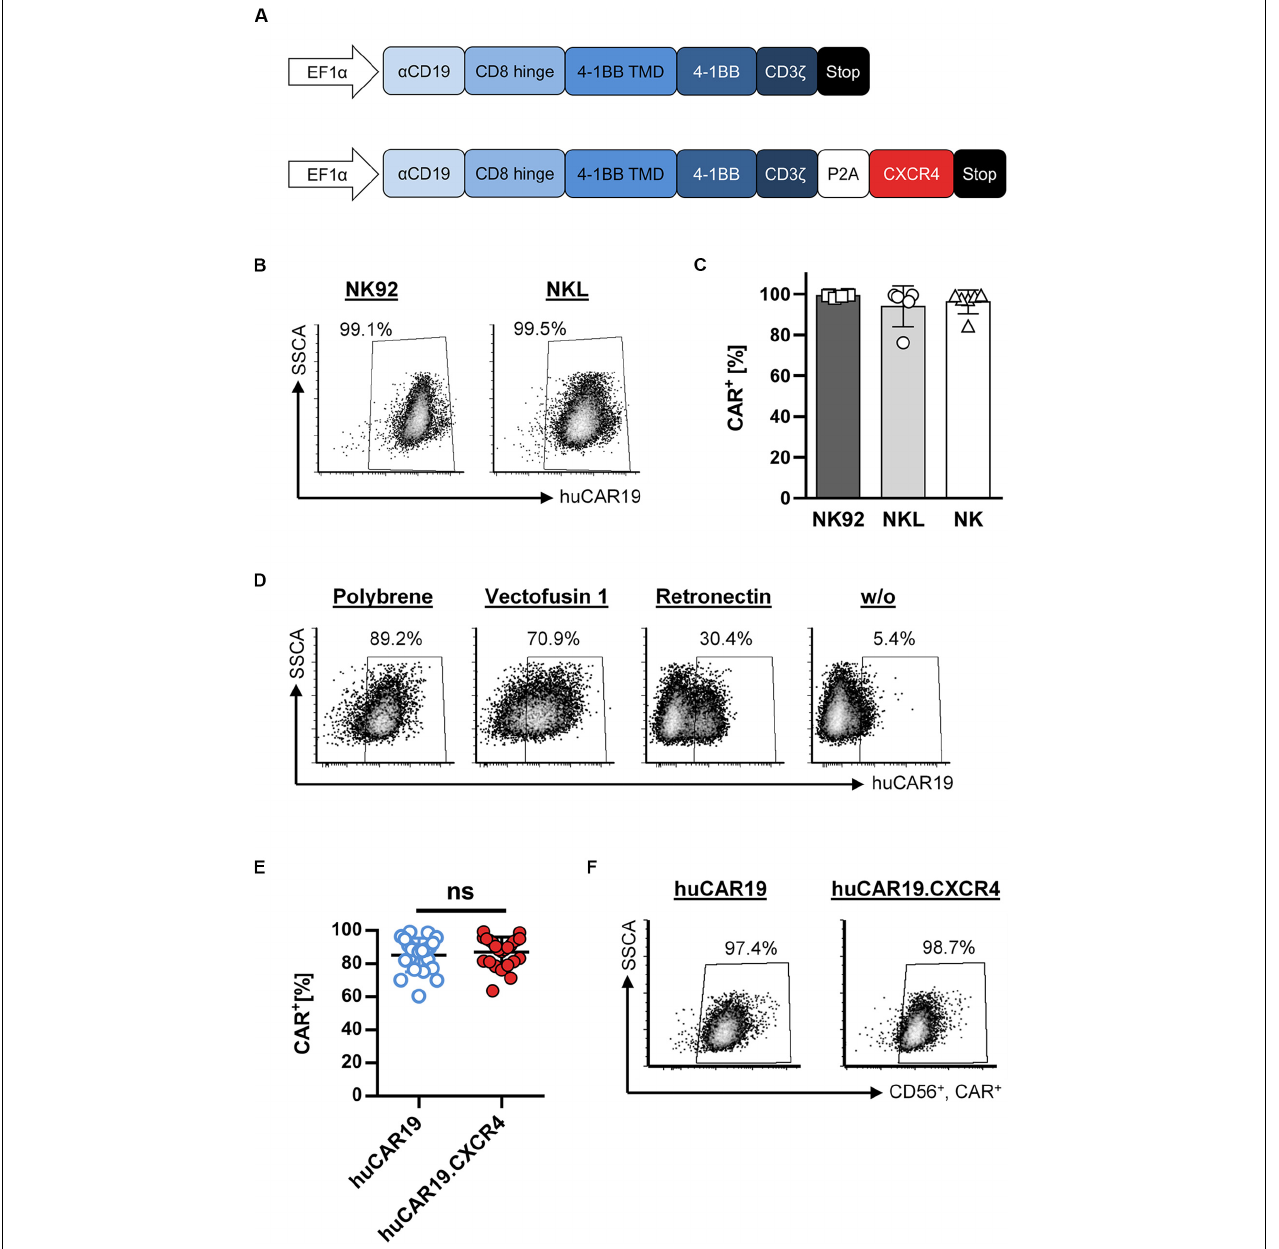
FIGURE 1 | Fully human CAR gene delivery to NK cells. (A) Schematic illustration of huCAR19 (top) and huCAR19.CXCR4 (bottom) constructs used to generate CAR NK cells. The second-generation fully human CAR consists of the anti-CD19 scFv derived from the human monoclonal antibody 21 Da ( α CD19) linked to the hinge domain of human CD8a (CD8 Hinge), the transmembrane and costimulatory domains of human 4-1BB (4-1BB TMD and 4-1BB), and the signaling domain of CD3 ζ . The coding sequence of human CXCR4 is connected to the CAR gene by a P2A self-cleaving peptide. Transgene expression is under control of the human elongation factor 1- α promoter (EFI- α ). (B,C) NK-92 and NKL cells as well as primary NK cells were transduced with huCAR19-LV particles in the presence of polybrene and analyzed for CAR expression 3 days post-transduction by flow cytometry. The percentage of CD19-CAR-positive cells is indicated. Each transduction experiment was performed at least five times. Representative dot plots for NK-92 and NKL-transduced cells are shown in B. Individual results of transduced NK-92, NKL, and primary NK cells are shown in C as a bar diagram with mean value and SD. (D) Effect of different transduction enhancers on huCAR19 gene delivery to primary NK cells; 3 × 10 4 primary NK cells were transduced with huCAR19-LV particles in the presence or absence of polybrene, Vectofusin-1, and Retronectin. 3 days post-transduction, huCAR19 transgene expression was detected by flow cytometry. Representative dot plots are shown ( n = 2, with technical replicates). The percentage of huCAR19-positive NK cells is indicated. (E,F) Addition of human CXCR4 sequence to the huCAR19 transgene did not impact huCAR19 expression. Primary NK cells of six different donors were transduced with huCAR19-LV or huCAR19.CXCR4-LV particles in the presence of polybrene. The percentage of CD19-CAR-positive cells was analyzed by flow cytometry 3 days post-transduction. Each transduction experiment was performed at least 10 times. Three to four individually produced vector stocks were applied. Individual results as well as mean value, SD, and significance are shown in E. Representative dot plots are shown in F. ns, not significant by unpaired t test ( p =